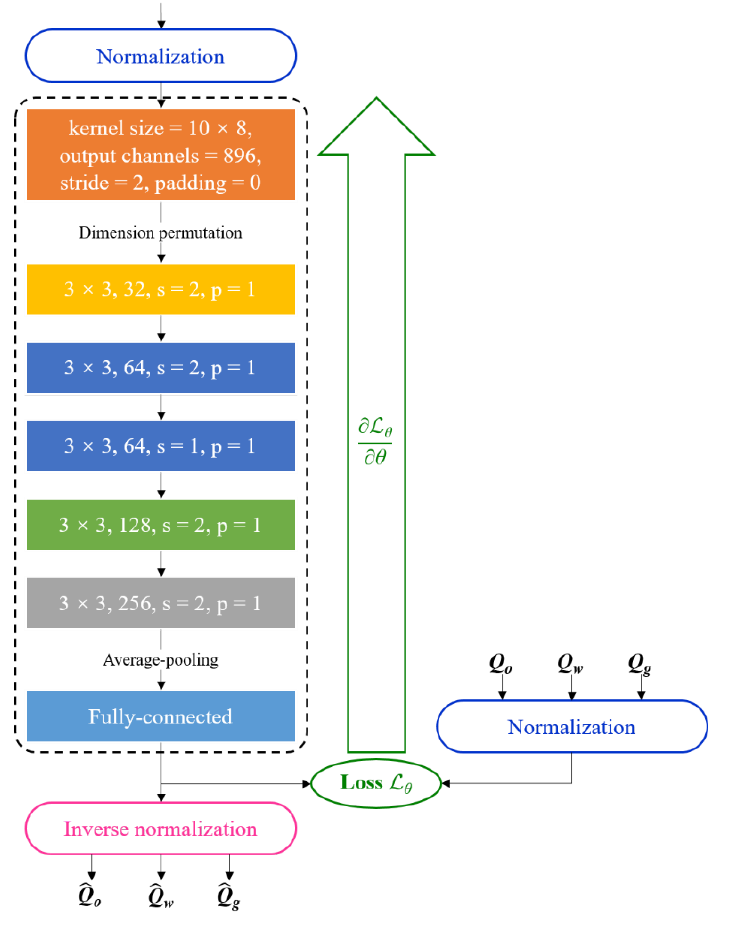
Figure 5. The architecture diagram of the convolutional neural network (CNN)-7-based prediction model for the volume flow rates of the individual phases.